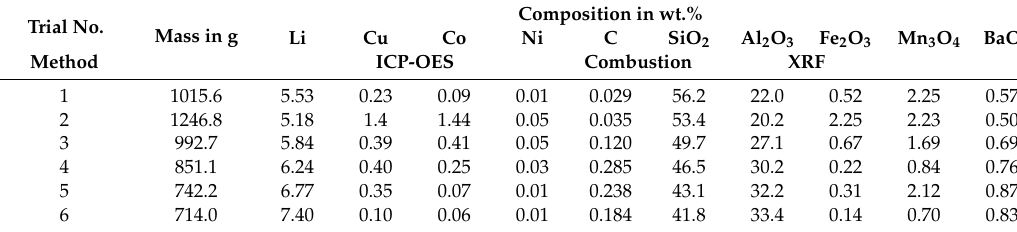
Table 4. Chemical analysis of bulk slag generated in the trials.